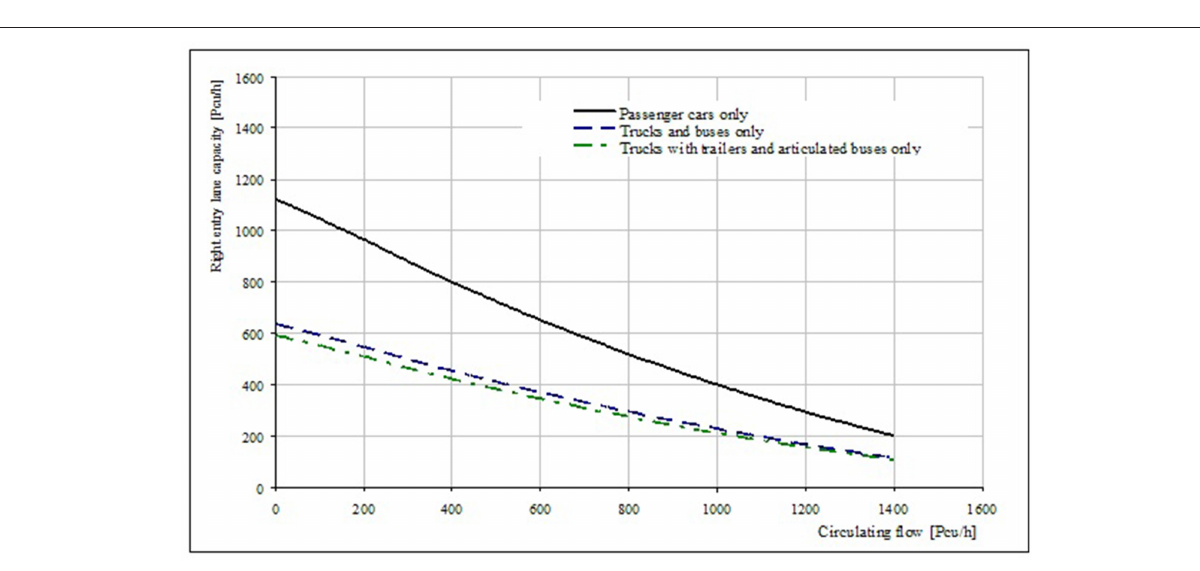
vehicles on the headway parameters should also be